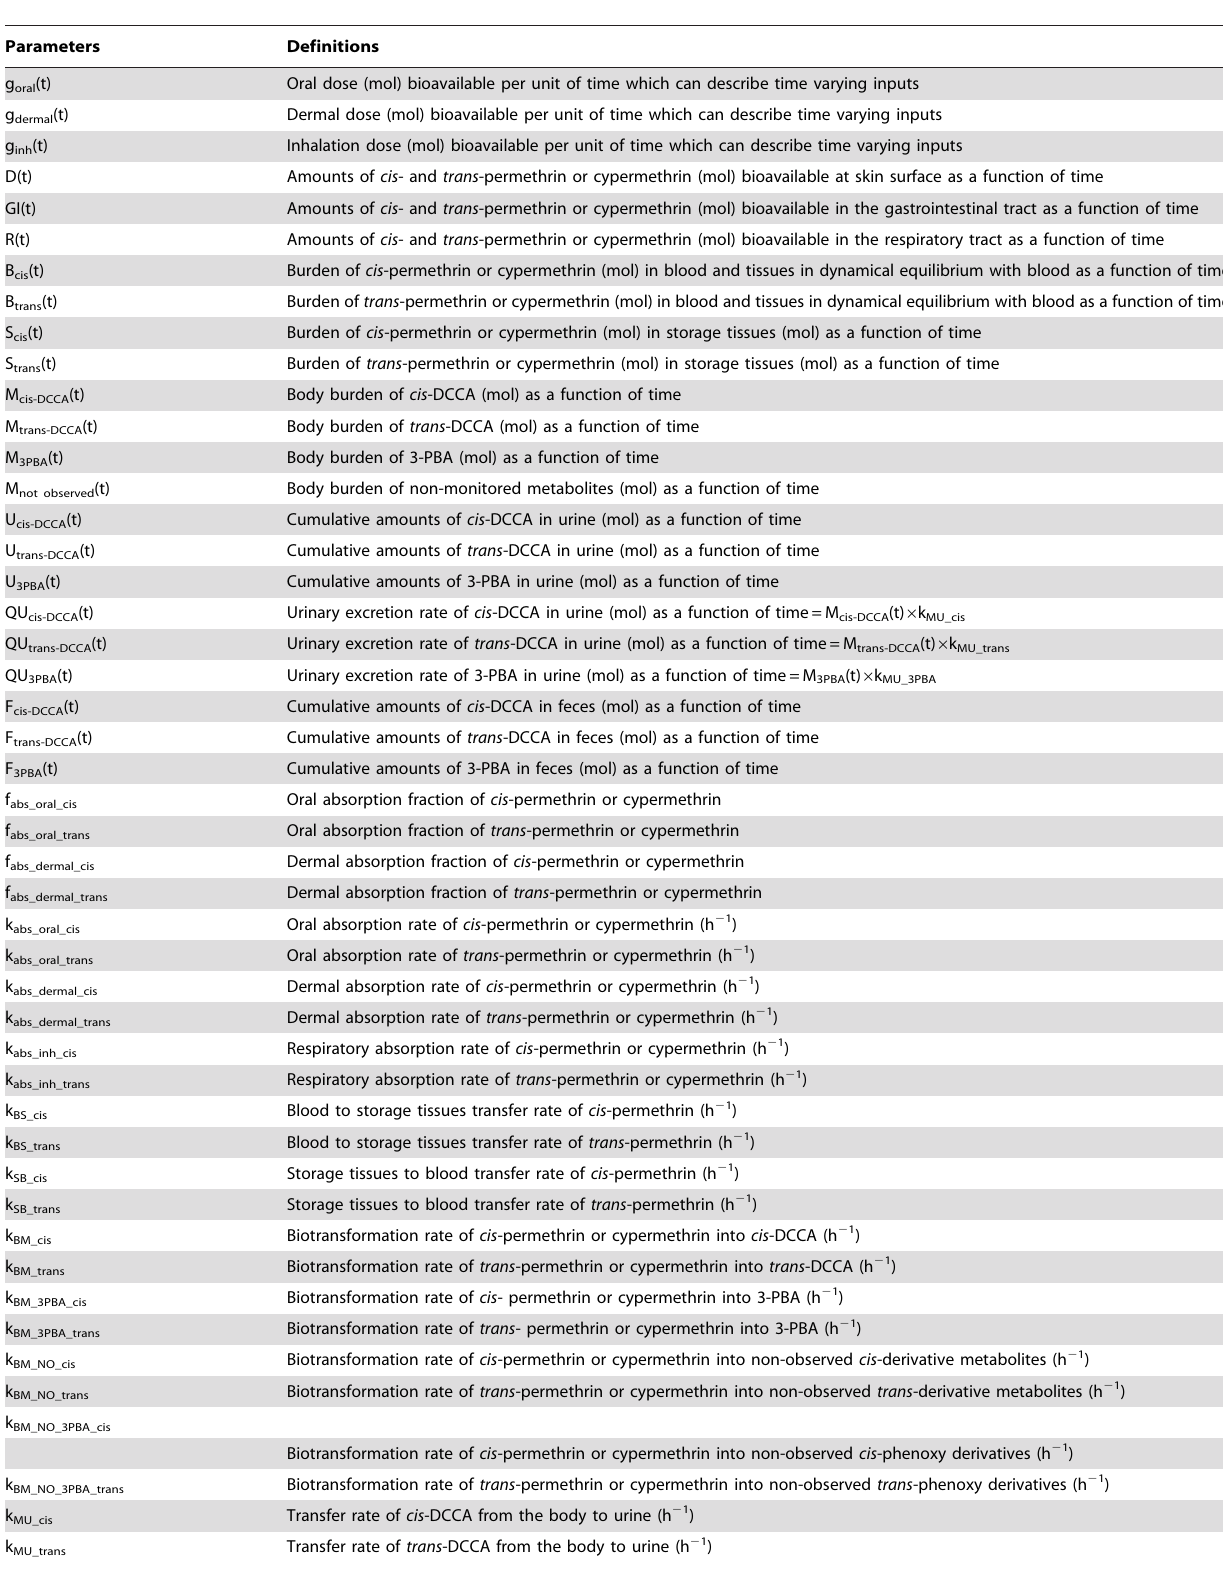
Table 1. Description of symbols used in the conceptual and functional representation of the kinetic model of permethrin and cypermethrin and their